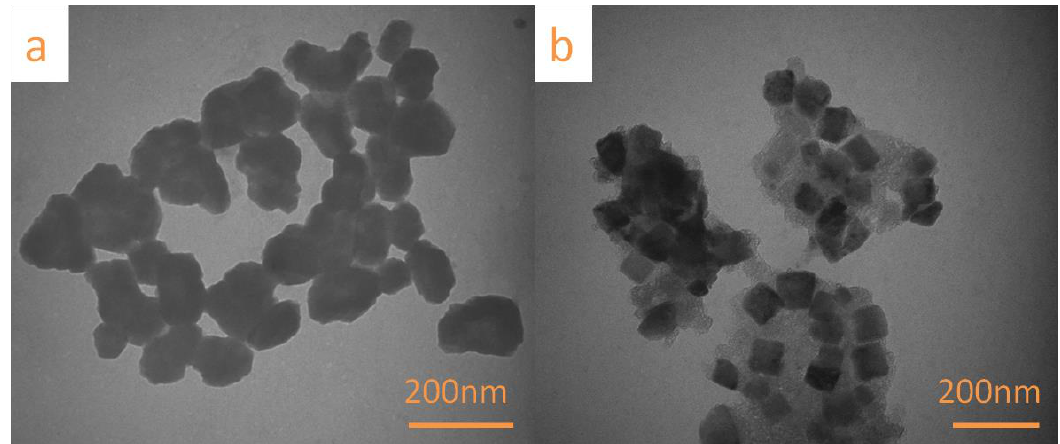
Figure 3. TEM images of ( a ) TNC and ( b ) SNC.